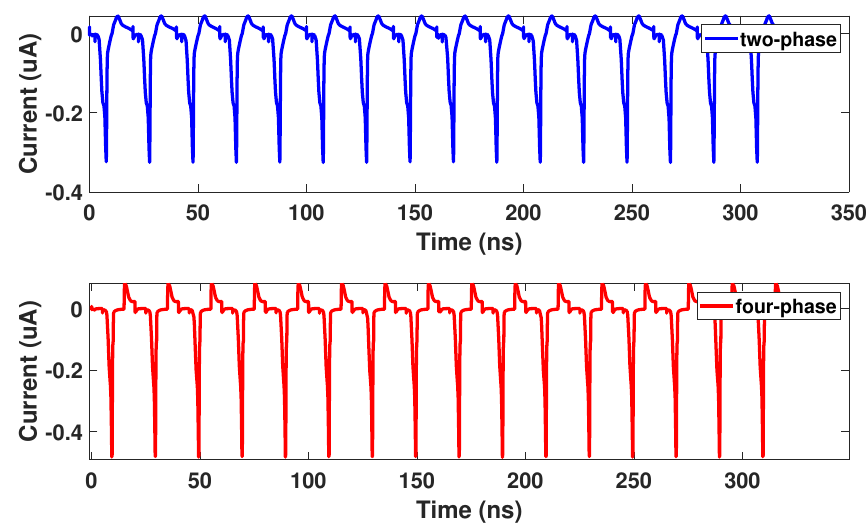
Figure 3. Uniform current consumption of an adiabatic logic gate.